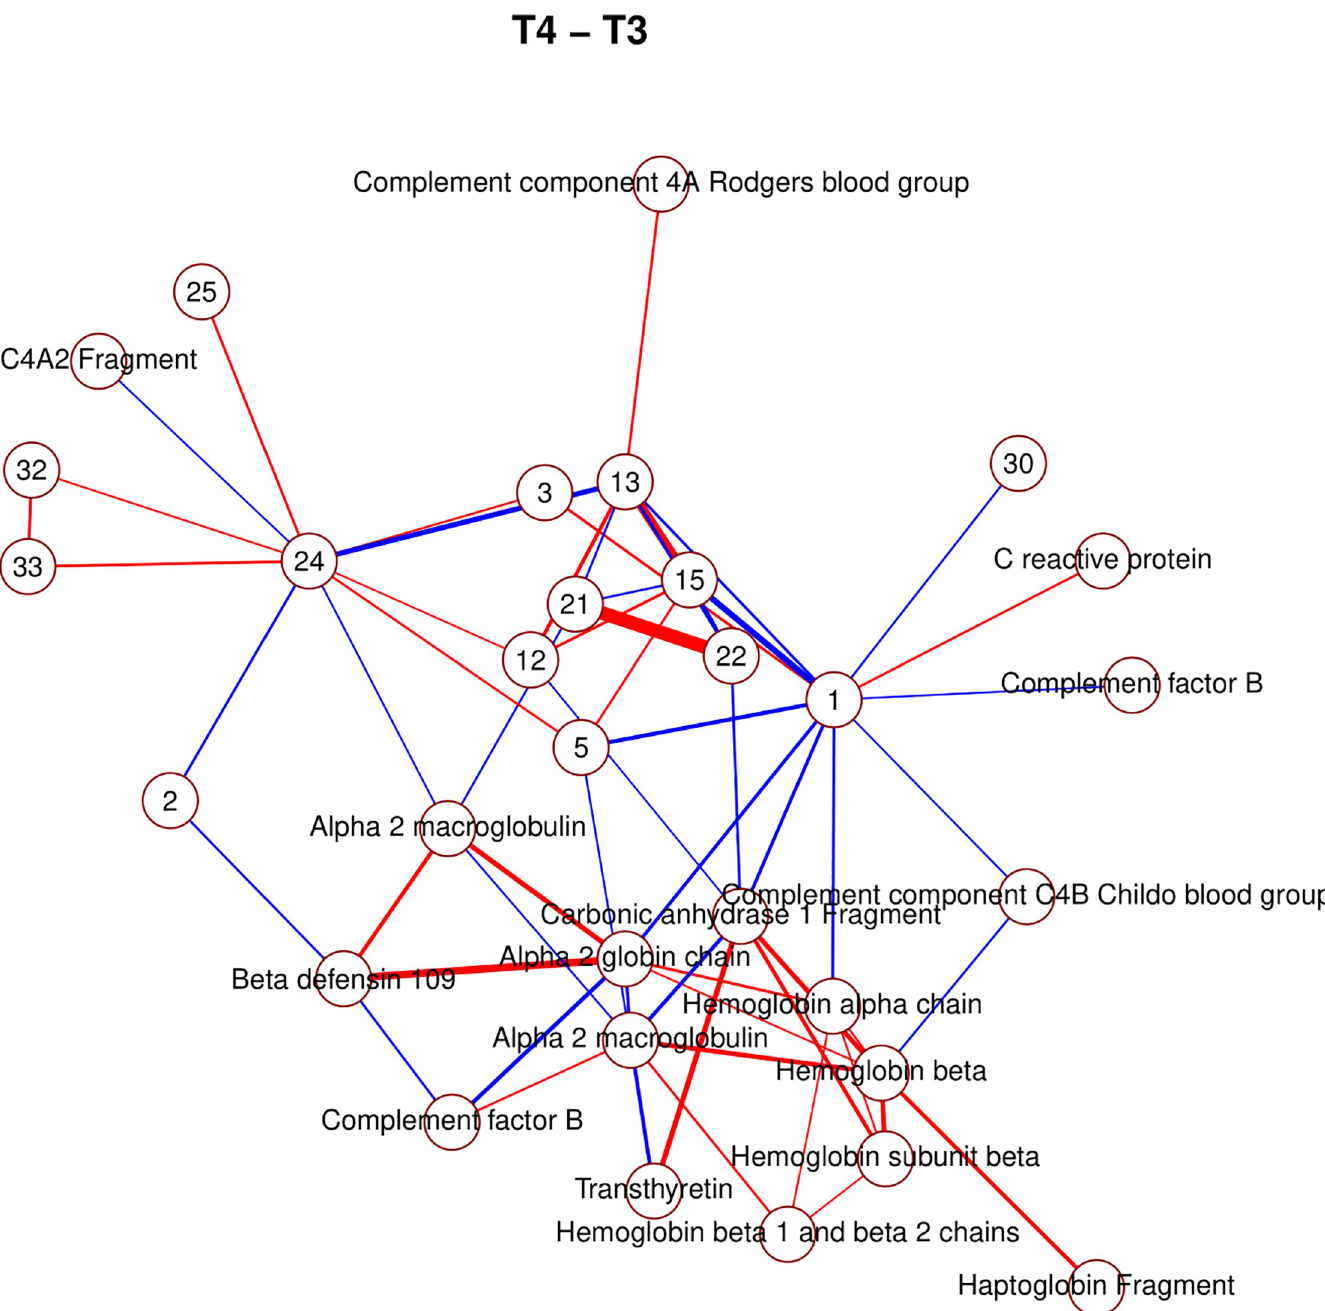
Fig 8. Non-zero partial correlations between differences in spot intensities from t 3 to t 4 displayed as a conditional independence network. Line width is proportional to the strength of the partial correlation and color represents positive (red) or negative (blue) partial correlation.